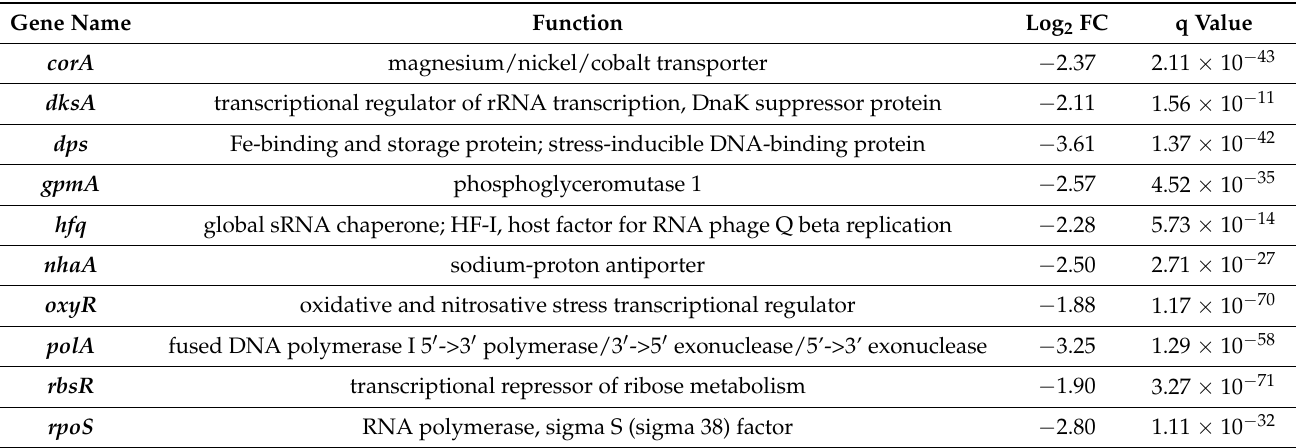
Table 3. Genes underrepresented in the H 2 O 2 condition of the TraDIS experiment. The gene function and the fold change compared to control are detailed.